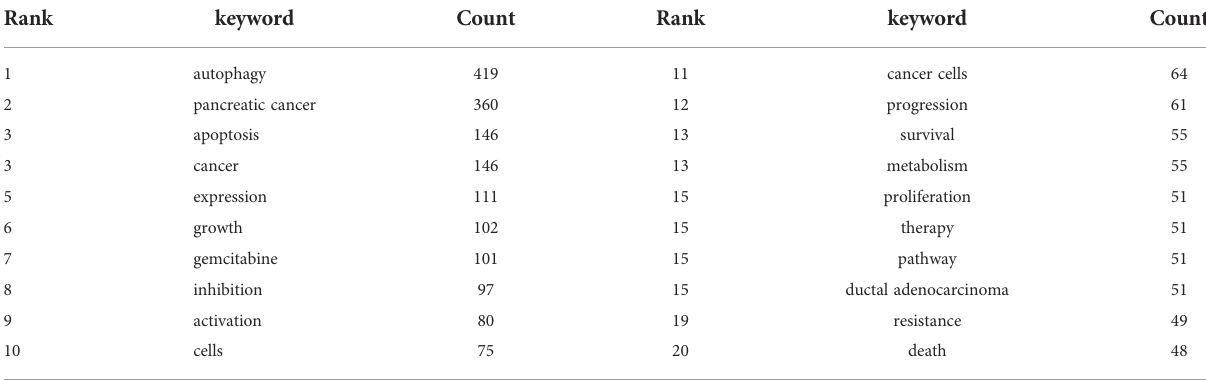
TABLE 8 The top 20 keywords related to autophagy of pancreatic